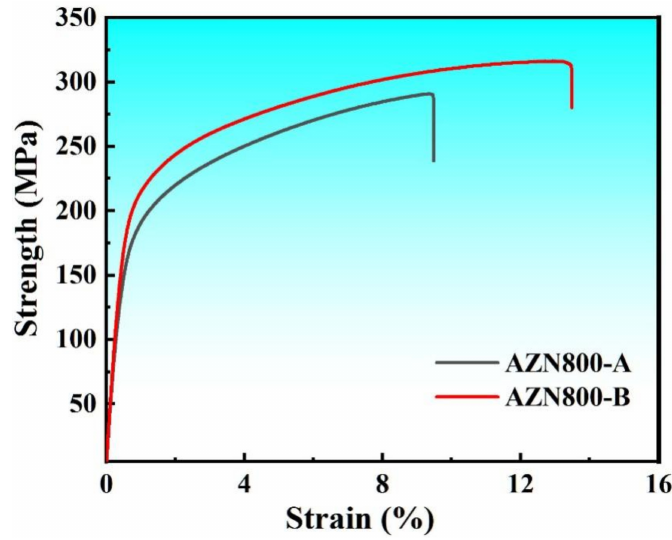
Figure 4. Engineering tensile stress–strain curves of the AZN800-A and AZN800-B alloys.